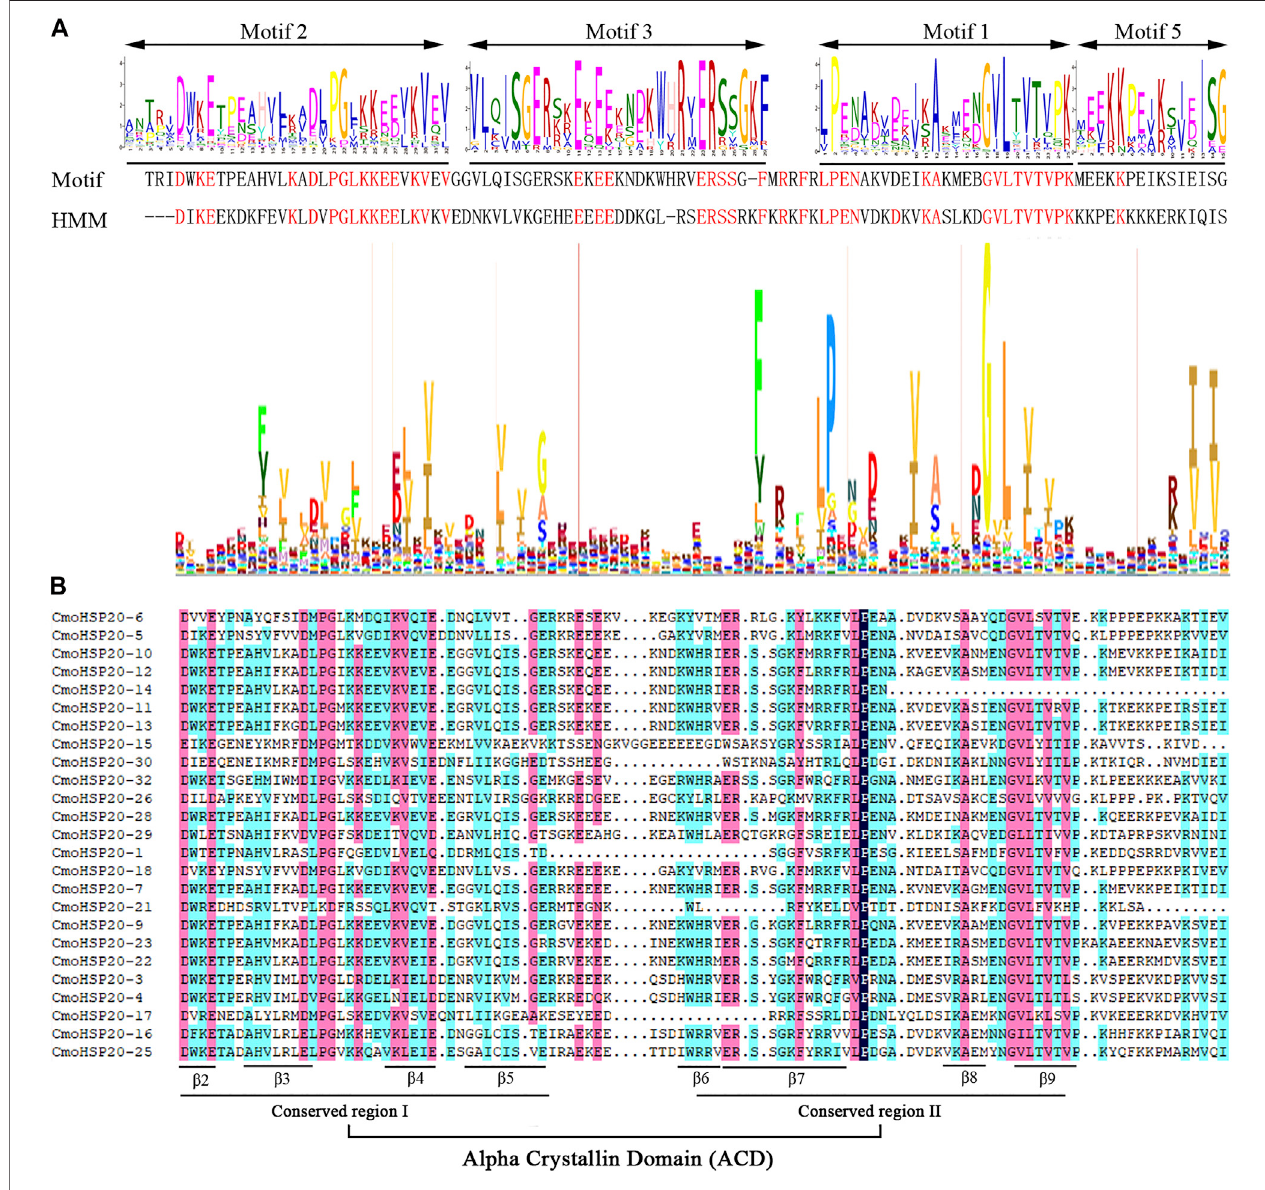
FIGURE3| AlignmentstheACDsofCmoHSP20s. (A) AlignmentoftheACDfromtheMEMEresultsfortheCmoHSP20.Themotif2,3,1,and5formedtheputative CmoHSP20 ACD, and the HMM logo from Pfam representing the HSP20 domain (PF00011). The red amino acids represent matches between the MEME motifs and HMMsequences. (B) AlignmentoftheACDsofCmoHSP20sfrom Cucurbitamoschata .Namesofallgenemembersareshownontheleftsideofthe fi gure.Theprimary structure of the ACD, including the conserved regions I (CRI), II (CRII), and β 6-loop, is shown at the bottom of the fi gure.